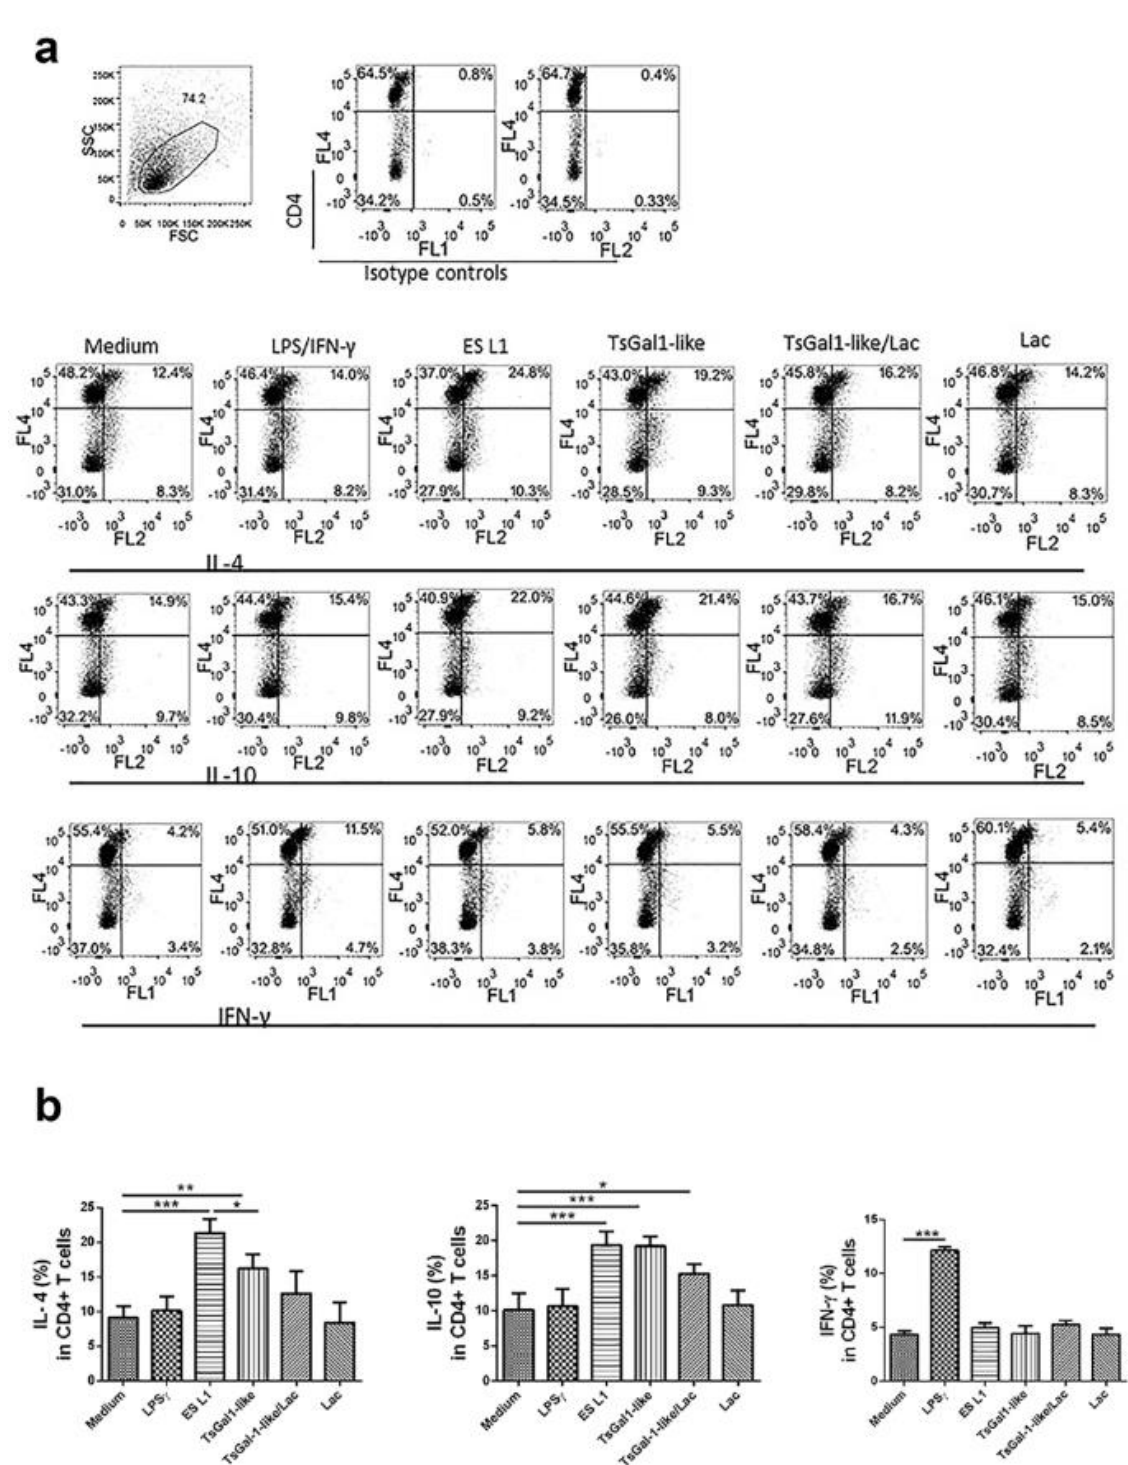
Figure 5: T helper polarization influenced by treated DCs . Treated DCs were thoroughly washed and then cocultured with magnetic-activated cell sorting-purified allogenic T cells (1 × 10 5 /well) for 6 days in 1:20 DC:T cell ratio. ( a ) Representative analysis of IL-4 + , IL-10 + and IFN-  + cells within CD4 + T cells from one experiment are shown. ( b ) Presented are the summarized results shown as mean % ± SD of three experiments with different DCs donors. *p < 0.05, **p < 0.01, ***p < 0.001 compared to control, or as indicated by line (one-way ANOVA with Tukey’s